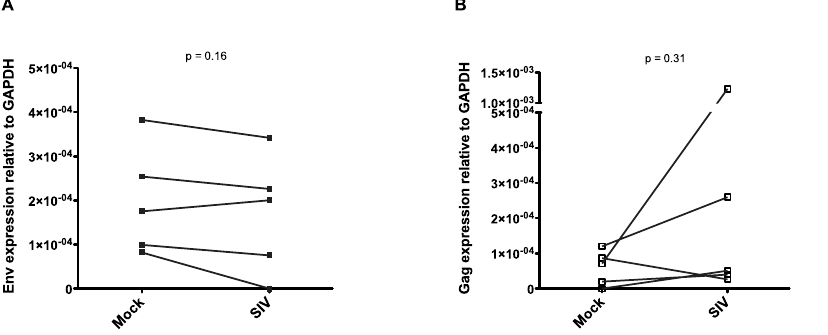
Figure 6. CyERV gene expression levels in CD4 + T-cells following invitro SIV infection. CyERV gene expression was quantitated by RT- qPCR using RNA isolated from mock- and SIV-infected CD4 + T-cells. CyERV envelope (A) and gag (B) gene expression levels relative to GAPDH are compared between in vitro mock- and SIV-infected CD4 + T-cells. Paired-samples t-tests (2-tailed) were performed to determine statistical significance.